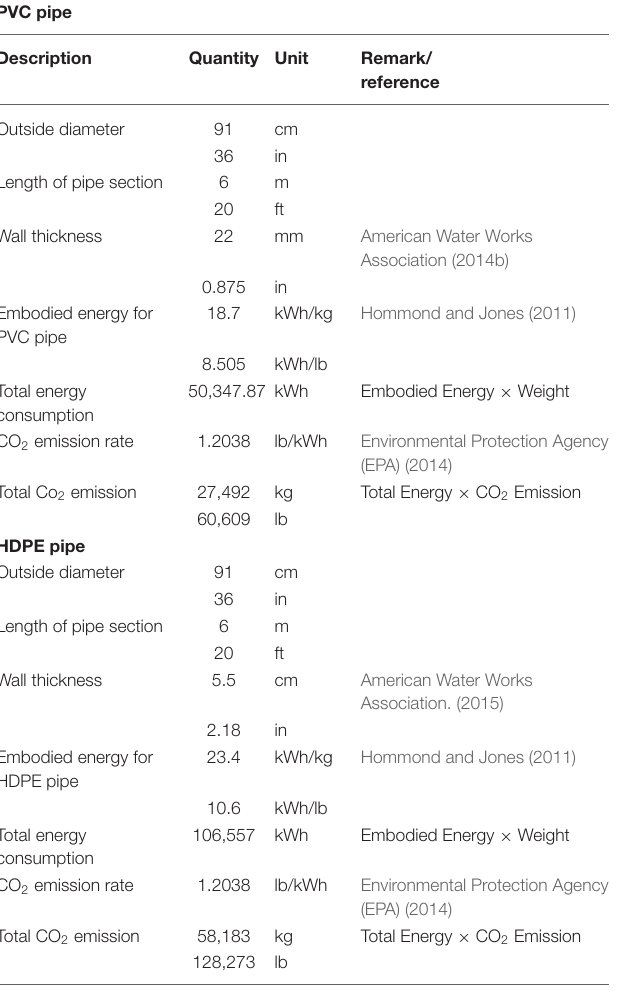
TABLE 2 | Carbon emission of PVC and HDPE pipe.